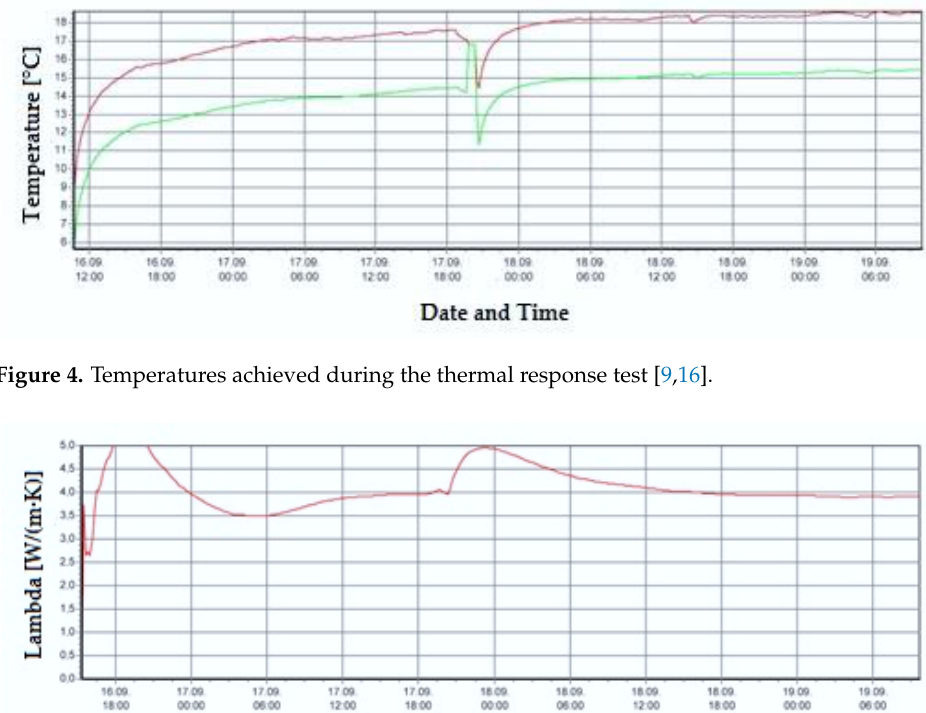
Figure 5. Thermal conductivity coefficient evaluation process [9,16].